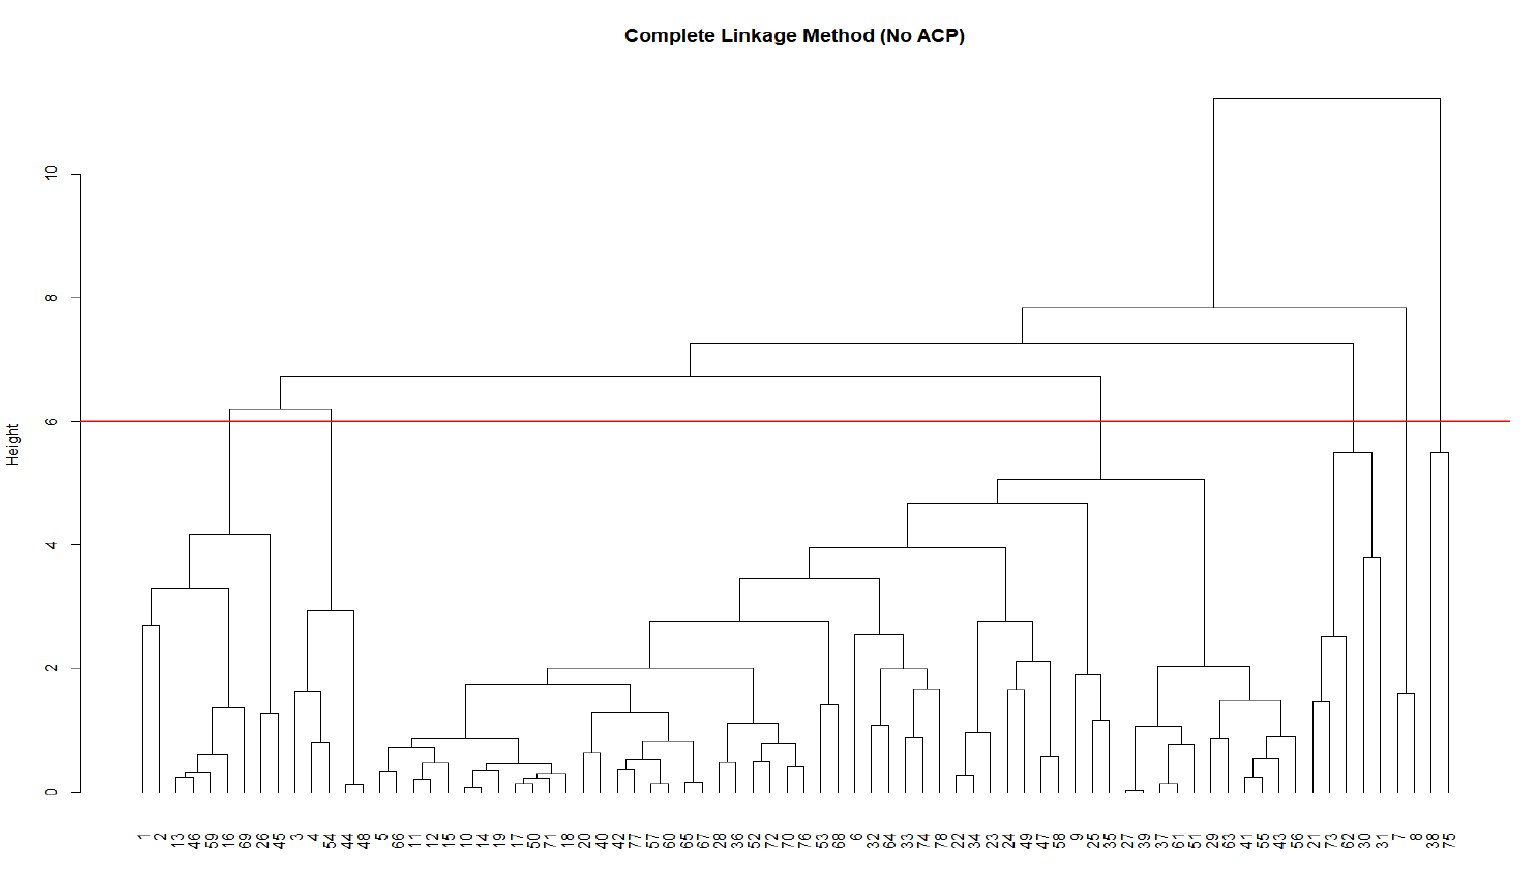
Figure A2. Dendrogram of the cluster analysis.